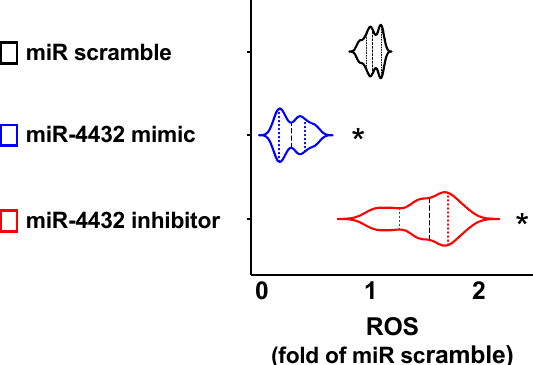
Figure 7. In hBMECs, the production of mitochondrial ROS (reactive oxygen species) was significantly diminished by miR-4432 mimic and increased by miR-4432 inhibitor. Mitochondrial ROS generation induced by Ang II (200 nMol, 4 h) was quantified using MitoSOX Red in hBMECs that had been transfected for forty-eight hours with the miRs indicated in the figure. All the assays were carried out at least in triplicate; the violin plots show the median (dashed line) and the quartiles (dotted lines); *: p < 0.01 vs. miR-scramble.